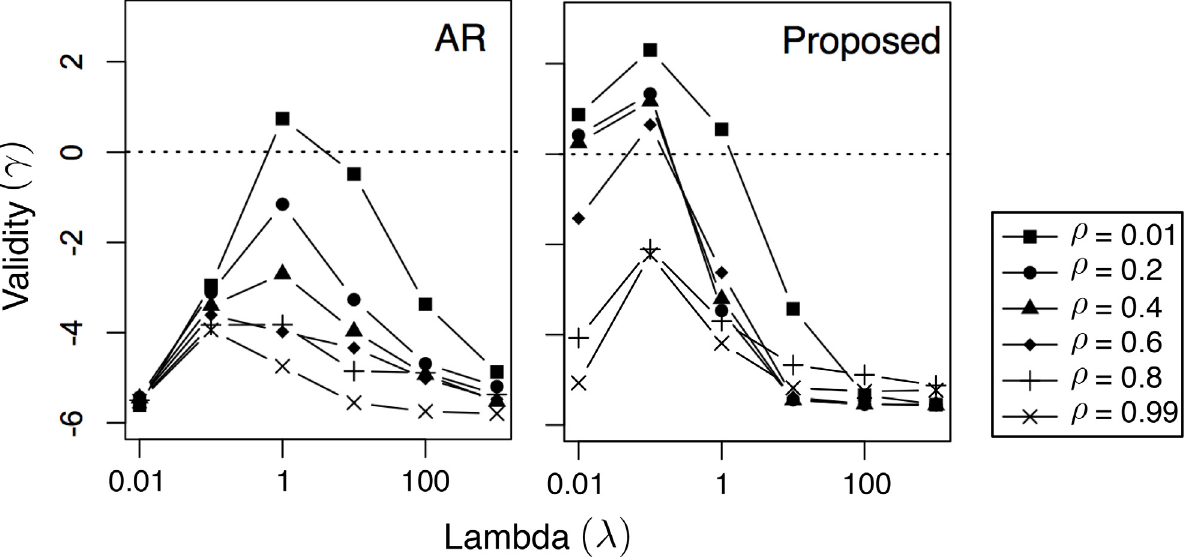
Fig 2. Influence of λ on solution validity γ using different values of ρ . The dotted lines mark λ (cid:9) 0, above which the solution is considered valid.